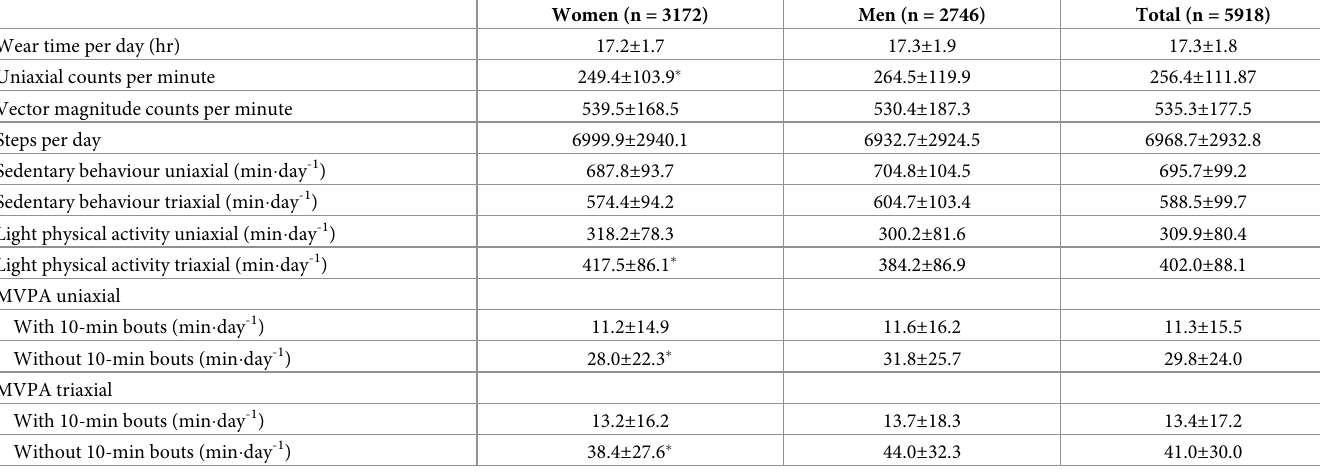
Table 3. Volume measures and intensity specific minutes per day by sex. The Troms ø Study accelerometry sample